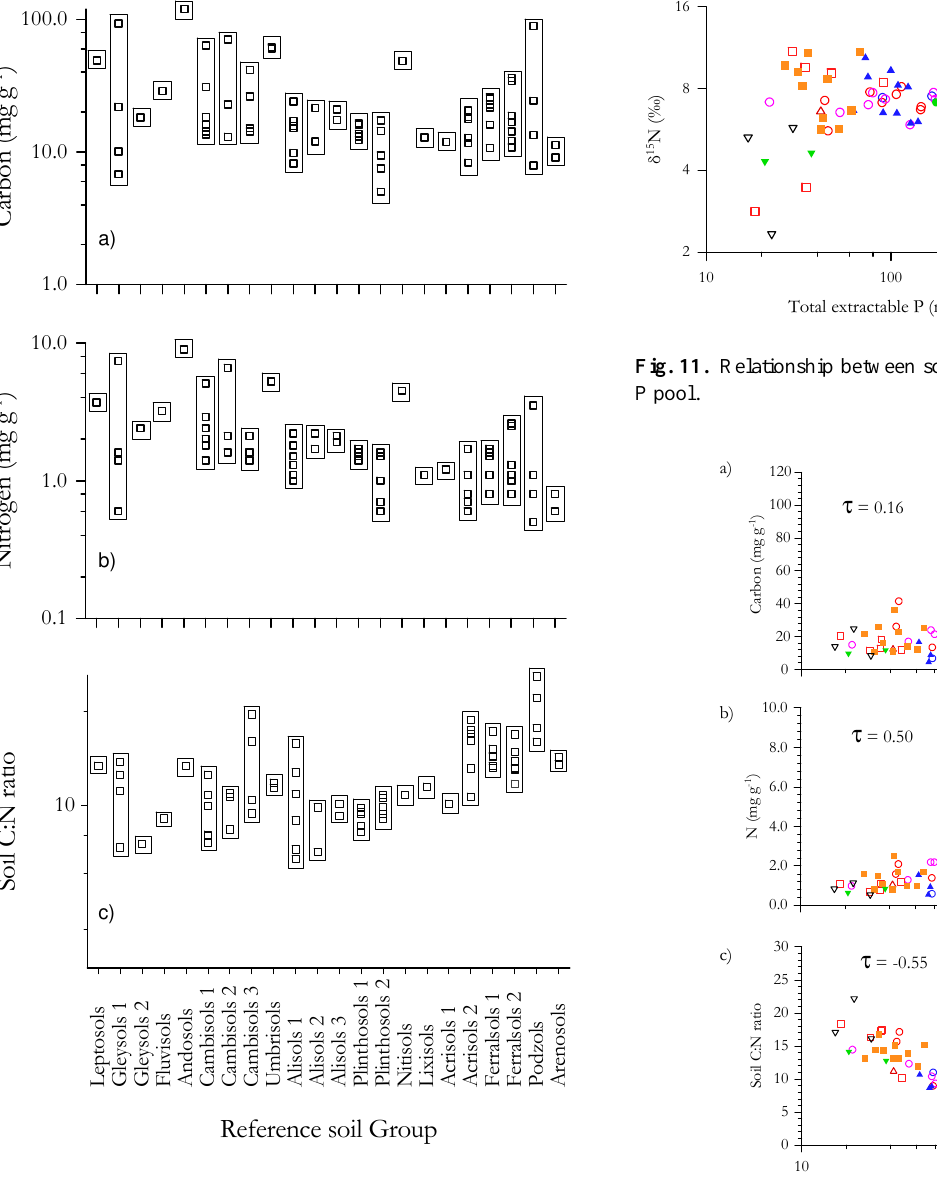
Fig. 10. Variations in soil carbon (top), nitrogen (mid) and C:N ratio (below) across the soil age gradient.